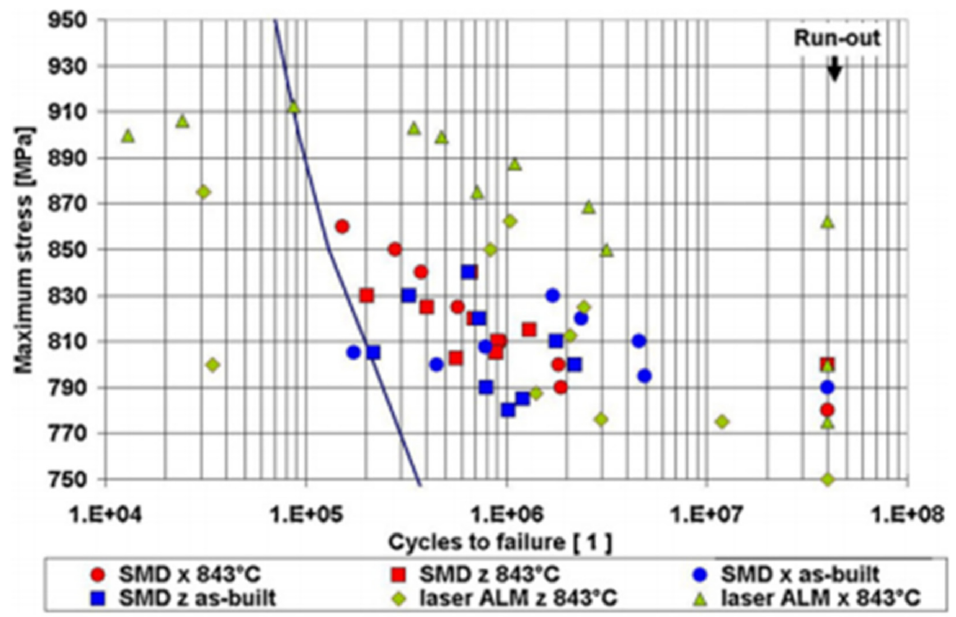
Figure 34. High cycle fatigue properties of a laser beam and SMD ALM specimens, tested along (x) and across (z) deposition direction; one data point represents one tested specimen. The line represents the upper fatigue limit required for wrought annealed